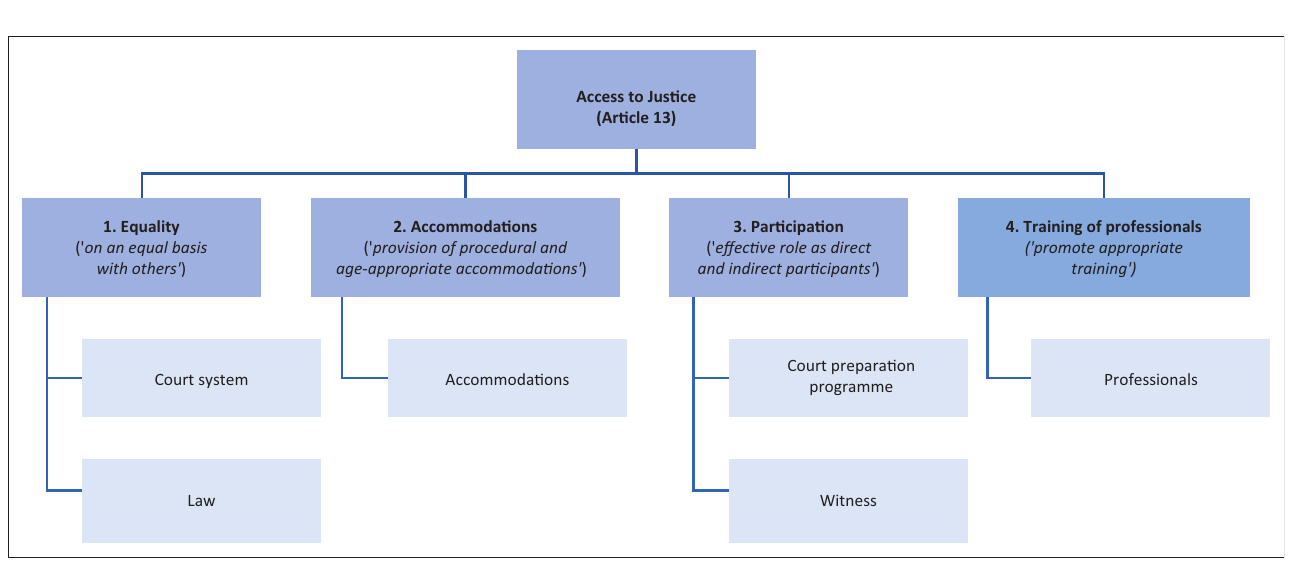
FIGURE 1: Conceptual framework, themes and